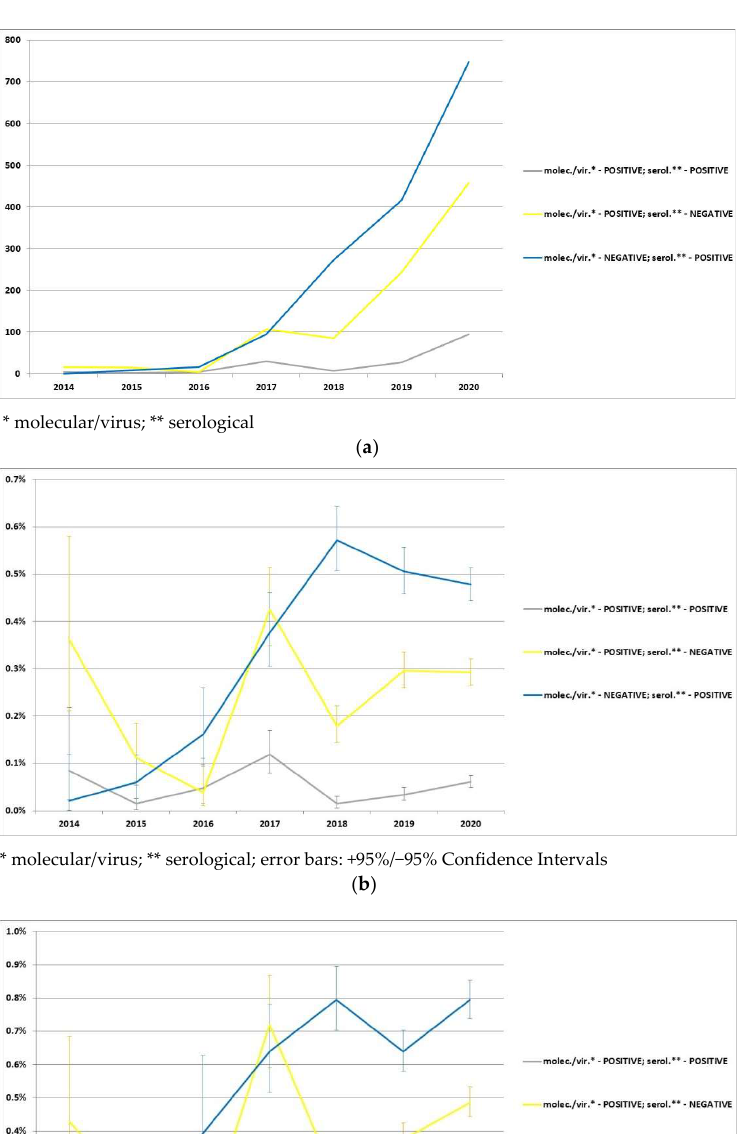
Figure 2. Wild boars tested for the presence of ASFV and/or antibodies against ASFV in Poland in the years 2014–2020: ( a ) percentage division of all analyzed wild boars; ( b ) percentage division of analyzed wild boars without ASF-negative animals.